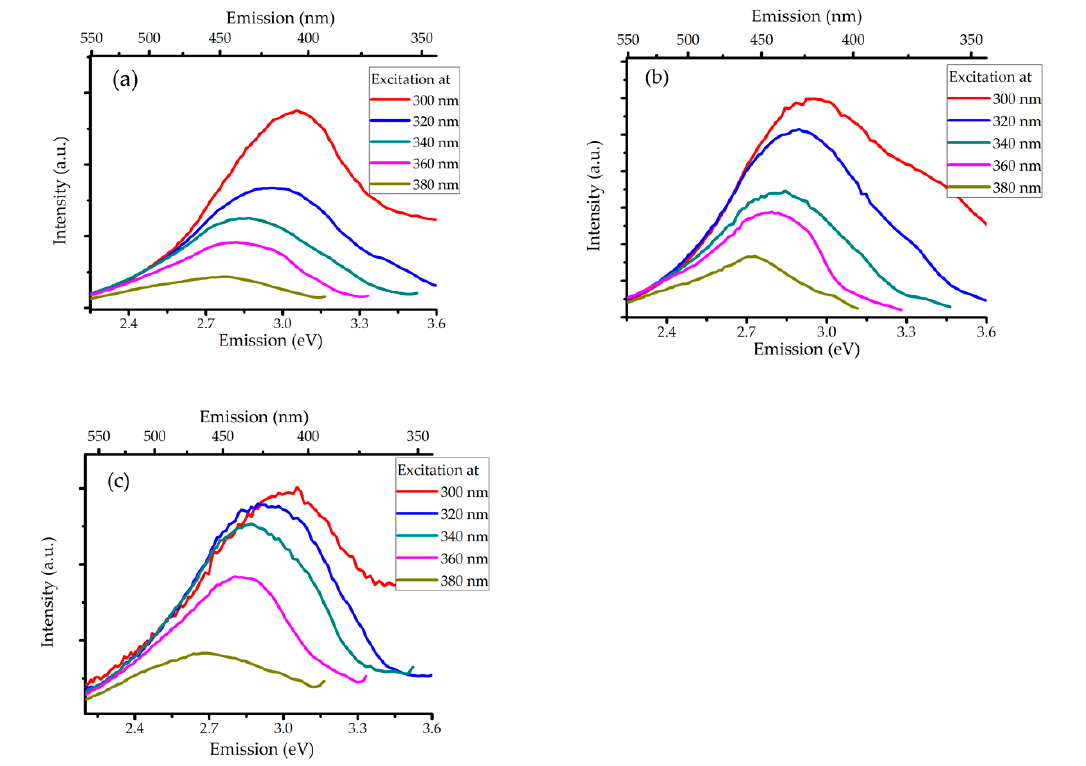
Figure 5. PL spectra of ( a ) the unseparated sample, ( b ) the permeate, and ( c ) the retentate.